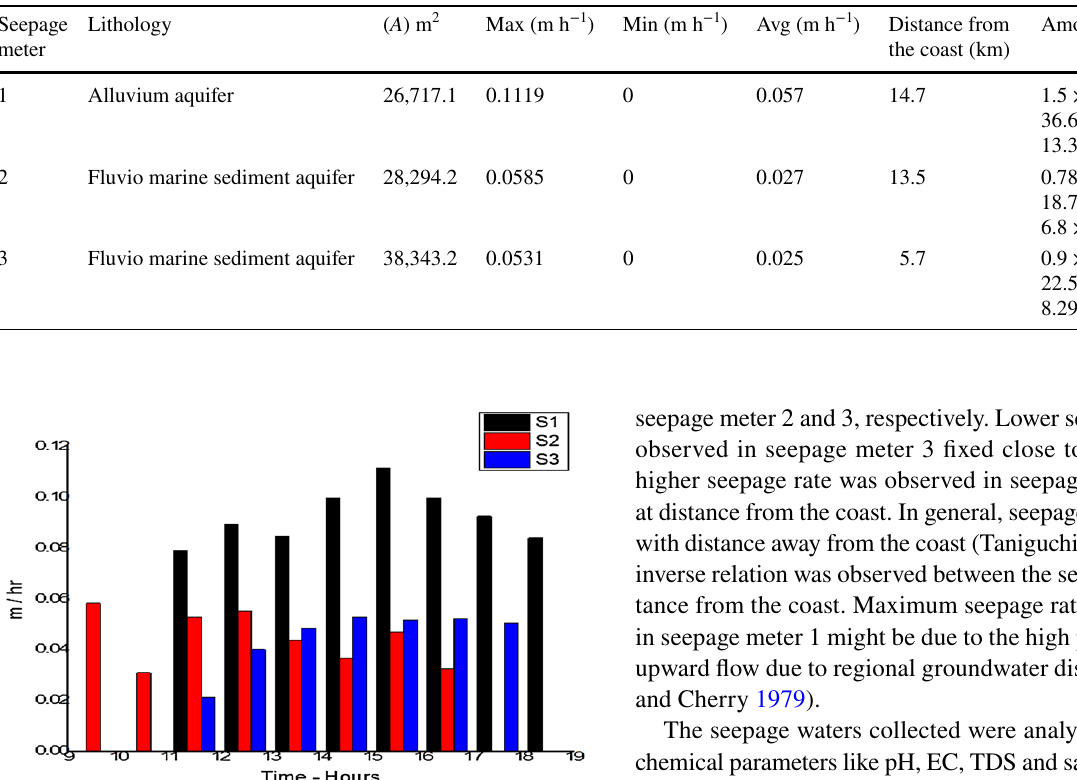
Table 3 Observed SGD in the study area